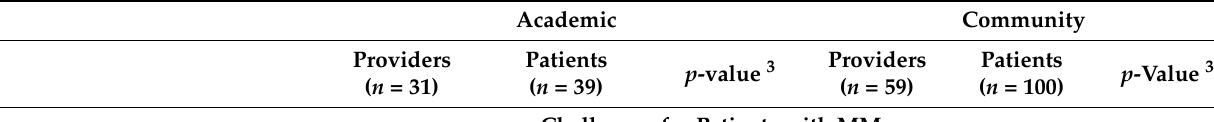
Table 3. Patient and Provider Tethered Survey